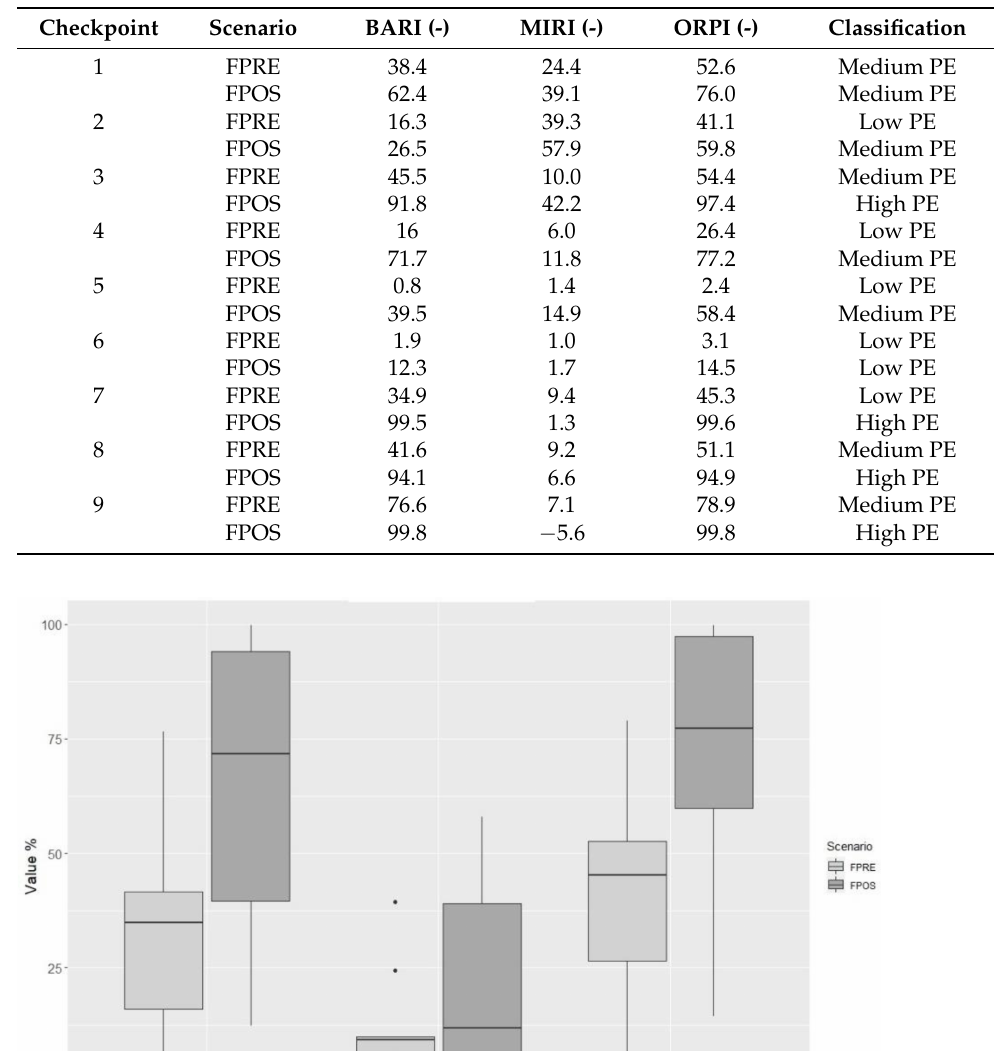
Table 4. Summary of Dupire’s indices. For each checkpoint the table shows the results of the three indices computation, BARI, MIRI, ORPI for both the FPRE scenario and the FPOS scenario. The last column reports the classification of the protective efficiency (PE) of the forest stand according to the scenario (the categories are based on [8]).